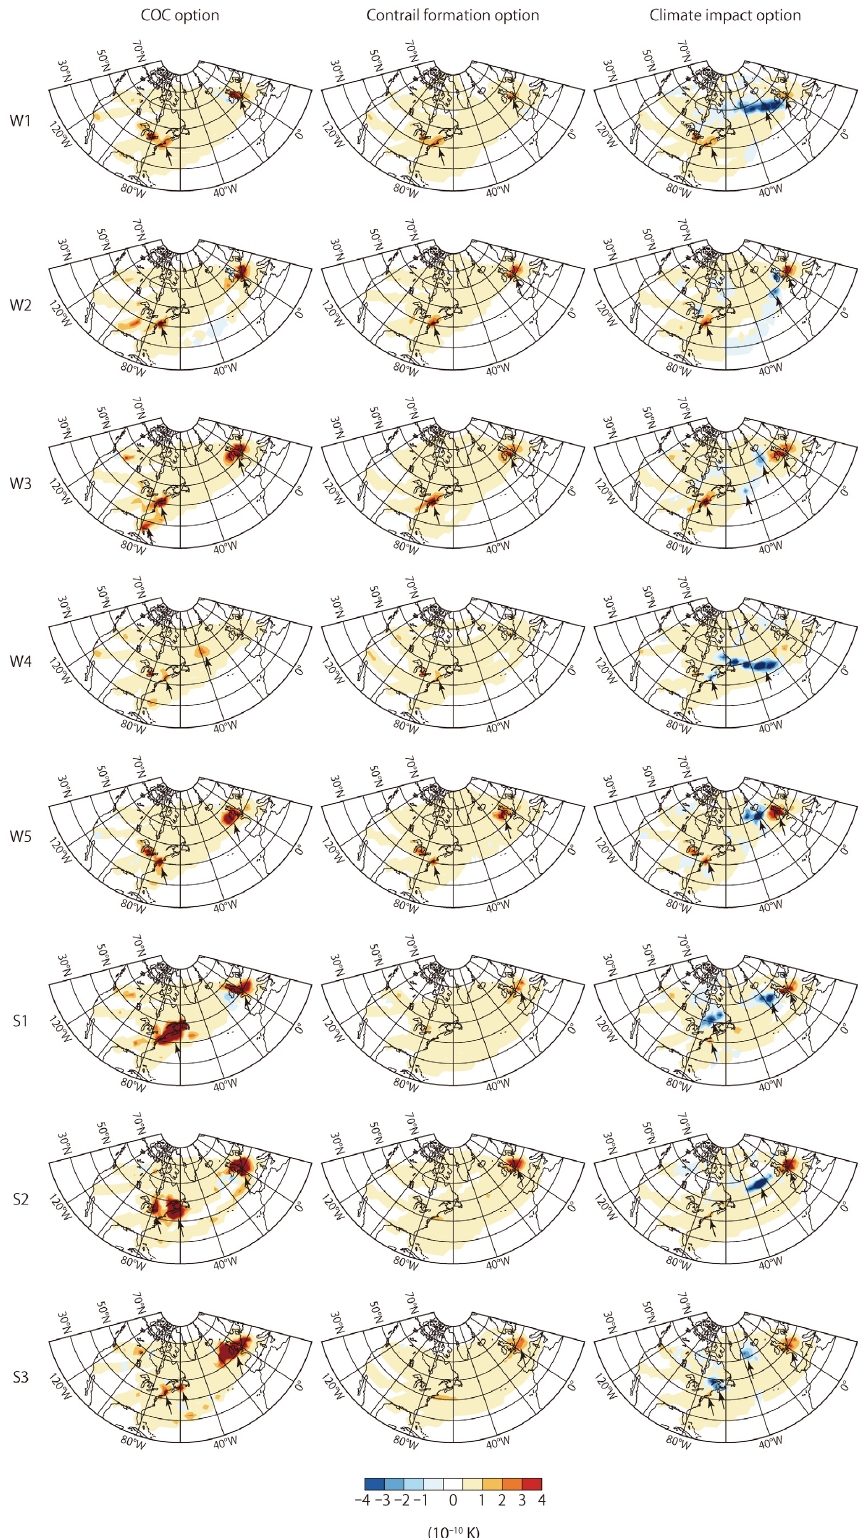
4 Figure 4. Vertically integrated distribution of the climate impact ( ATR20 to W5) and in summer (types S1 to S3); those values are calculated by the aCCFs : ( left ) COC option; ( center ) contrail option; and ( right ) climate option. The distributions represent the sum of 103 flights for 24 h of the respective days. The arrows indicate the region where the climate impact changes